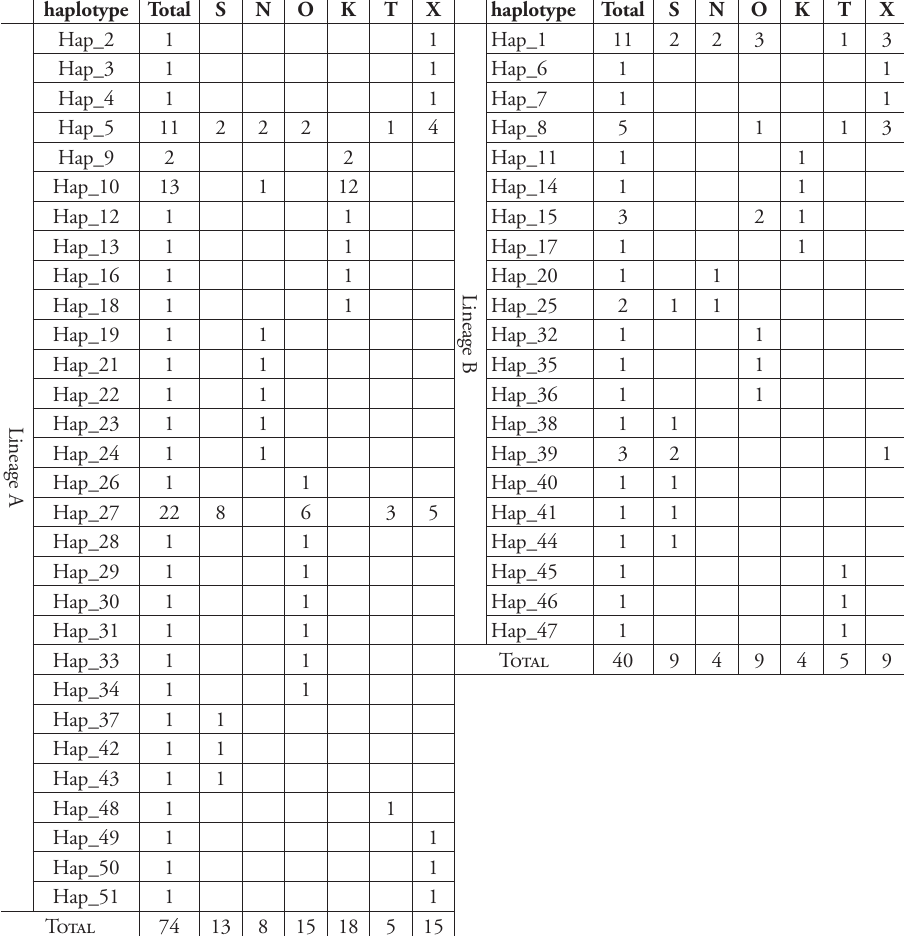
Table 2. Distribution of haplotypes among all silver pomfret populations in lineage A and B. haplotype Total